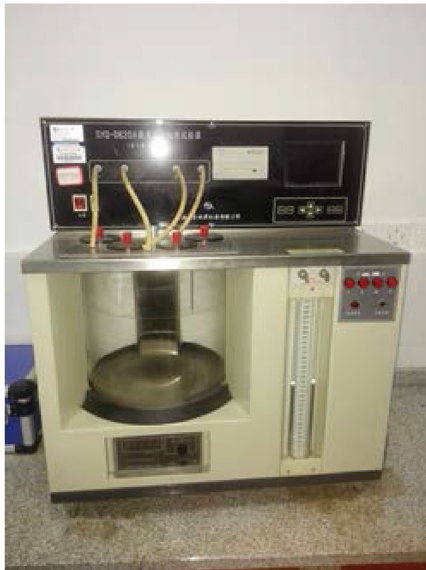
Fig. 2 Dynamic viscosity test